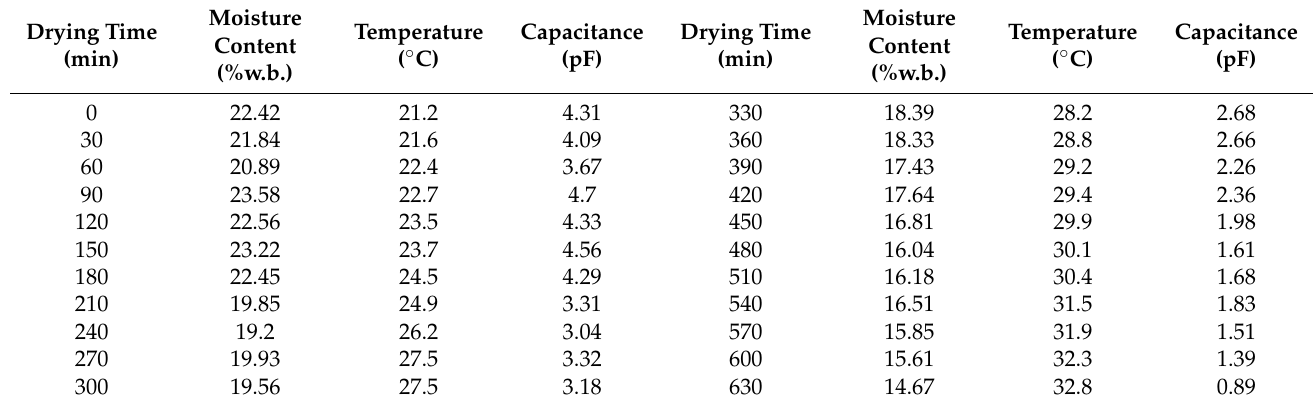
Table 1. Experimental values of response variables for the calibration experiment.